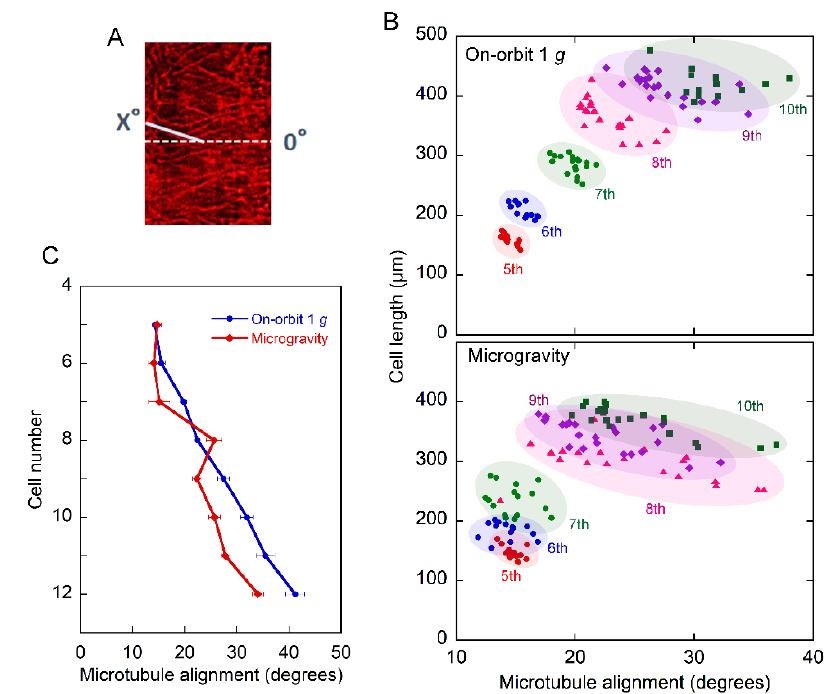
Figure 3. The alignment of cortical microtubules in each cell number of the epidermal cell file. Columbia seedlings were grown and their cortical microtubules were observed as described in Materials and Methods: ( A ) The transverse orientation to the long axis of the cell was defined as 0 ◦ and the angle of each cortical microtubule was measured for each cell; ( B ) The relationship between the cell length and the alignment of cortical microtubules in each cell of each cell number in the epidermal cell file. The cell length was measured as shown in Figure 1 and the alignment of cortical microtubules (average of 200 measurements) in individual cells as in Figure 3A; ( C ) Changes in the average alignment of cortical microtubules along the epidermal cell file. Data were taken from 14–24 different cells in each cell number and shown as means ± SE ( n = 14–24). Values are significantly different between the on-orbit control and microgravity ( p < 0.05), except for cells 5, 6, and 8.